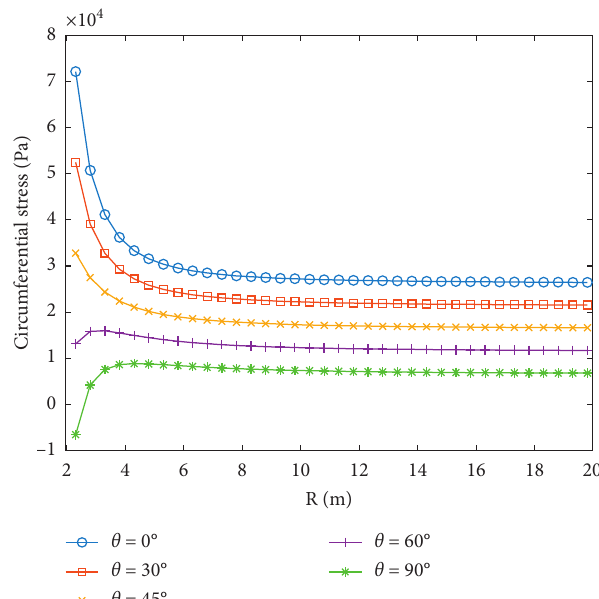
Figure 8: Circumferential stress under the in situ stress of sur- rounding